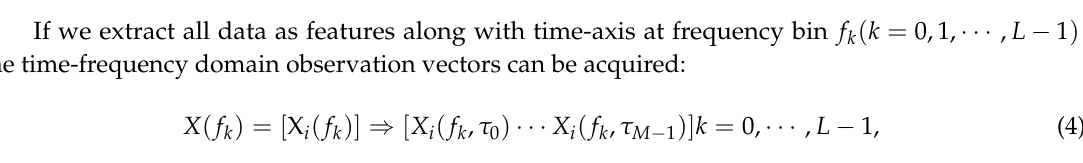
Table 1. Time-domain Eye Movement Features.